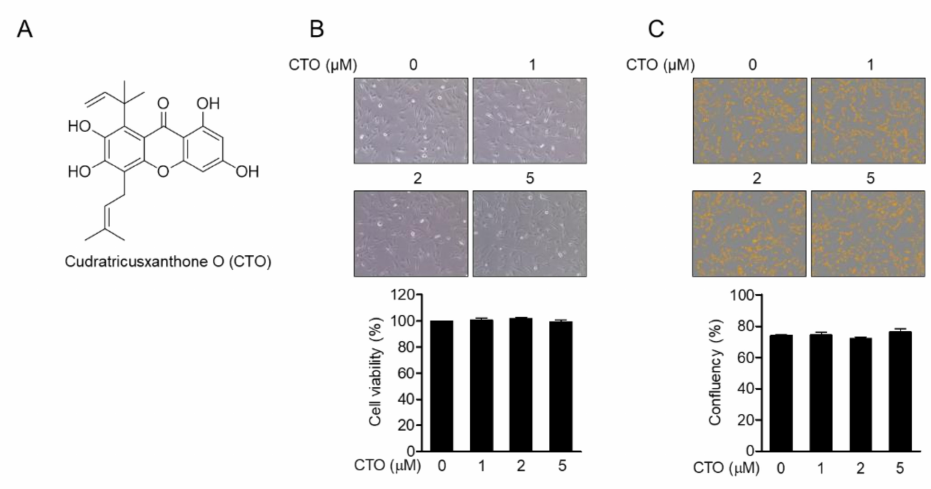
Figure 1. Cudratricusxanthone O (CTO) is not cytotoxic to SW1353 chondrocytes. ( A ) The chemical structure of CTO. ( B ) SW1353 chondrocytes were seeded at a density of 1 × 10 4 cells / well and treated with CTO at the indicated concentrations (0–5 µ M) for 24 h, then after CTO cytotoxicity was evaluated by 3-(4,5-Dimethylthiazol-2-yl)-2,5-diphenyltetrazoliumbromide (MTT) assay. ( C ) The confluency of cells was determined using IncuCyte imaging system. The Student’s t -test was used for statistical